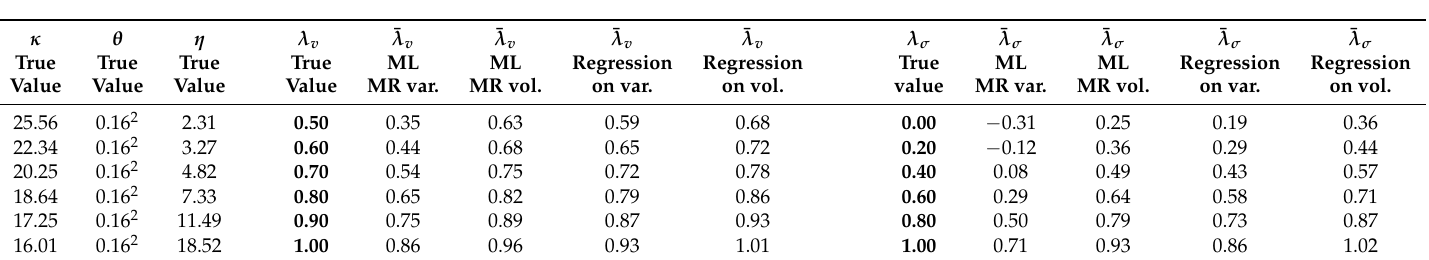
Table 1. The accuracy when estimating the elasticity parameters λ v and λ σ under various modeling assumptions (mean-reverting variance or volatility) and various estimation techniques (maximum approximate likelihood estimation and regressions). The experiment was conducted as follows: assuming either Model (3) or Model (5), we first simulated N = 1000 independent paths across 4935 days with 10 simulation steps per day. Here we used the locally log-normal scheme from Andersen and Brotherton-Ratcliffe (2005) as presented in Lord et al. (2010). Using only the 4935 daily values we then path-by-path estimated the λ v and λ σ parameters using each of the four estimation techniques. This gave us 1000 estimates for each, which we write as { ˆ λ v , i } N estimate the means E ( ˆ λ v ,1 ) and E ( ˆ λ σ ,1 ) for each estimation technique. These values should then be compared to the true values used to simulate the paths (columns 4 and 9 below) to see how biased each method is. The means can naturally be estimated by the averages ¯ λ σ = 1 (columns 10–13). To get an idea of how reliably ¯ λ v and ¯ λ σ estimate the means of each method, we can also compute standard errors as ˆ ν v / (cid:113) (cid:113) (cid:0) ˆ (cid:1) 2 (cid:0) ˆ (cid:1) 2 1 1 ∑ N ∑ N λ v , i − ¯ λ v λ σ , i − ¯ λ σ have defined ˆ ν v = and ˆ ν σ = . While we do not show the standard errors, we can report that they were all less than i = 1 i = 1 N − 1 N − 1 0.01.